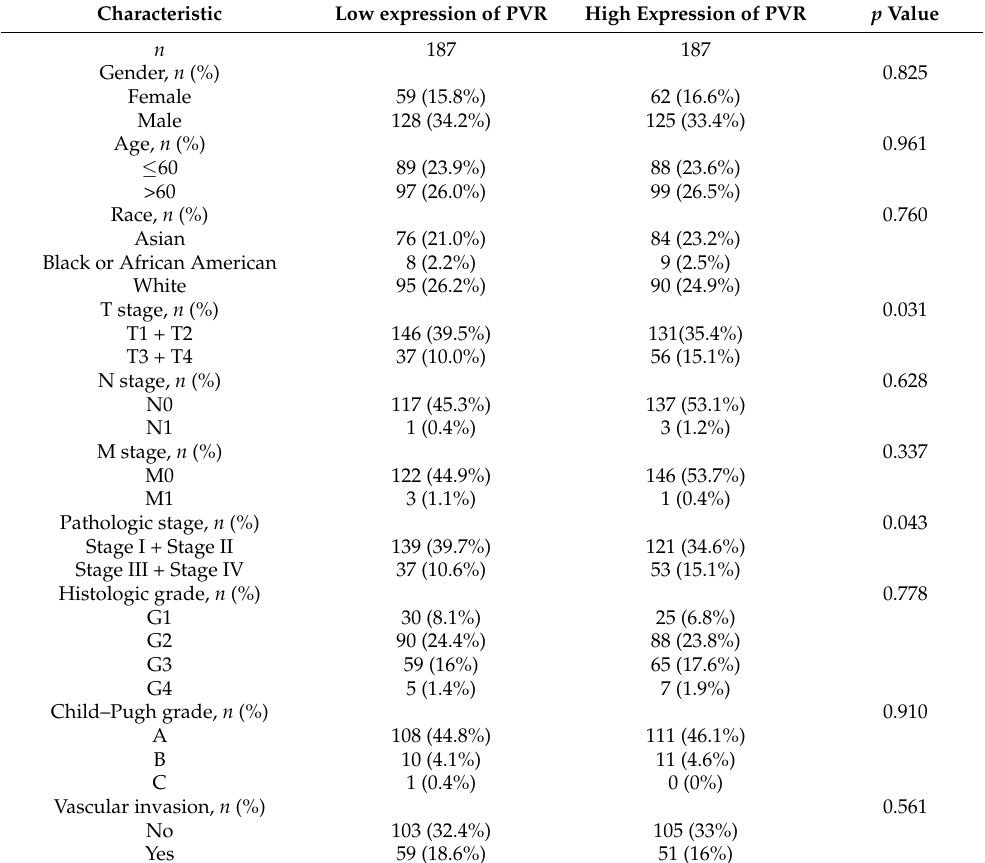
Table 1. Correlation of PVR mRNA expression and the clinical characteristics of HCC